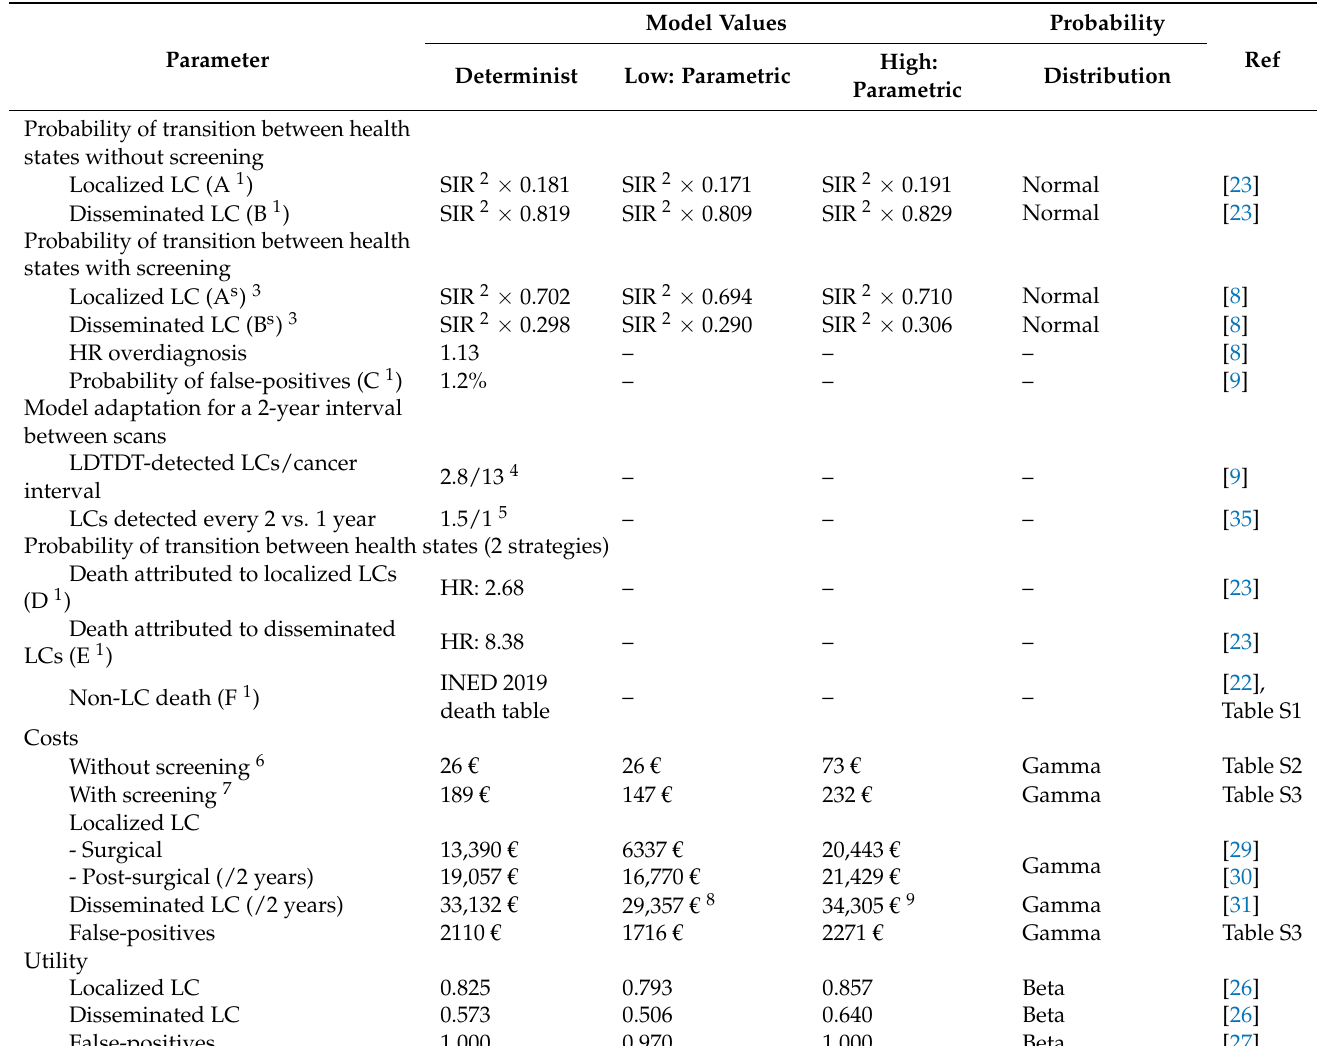
Table 3. Main Analysis Model